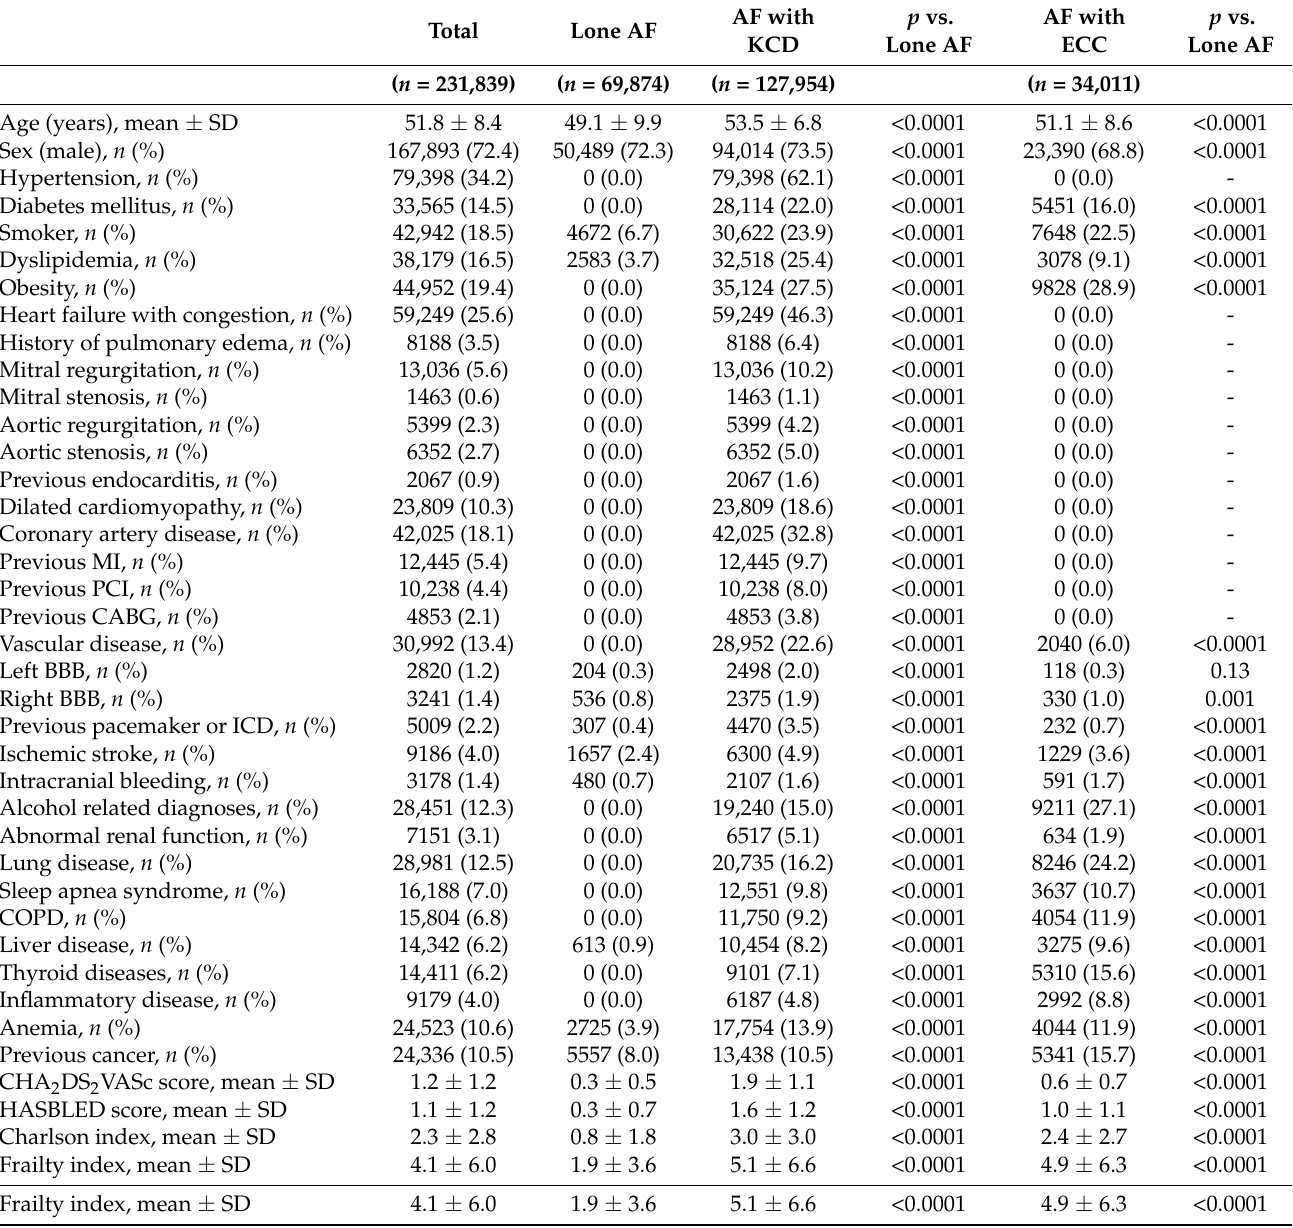
Table 1. Baseline characteristics of patients hospitalized in France (2011–2020) aged 18–60 with history of AF (KCD: known cardiac disease; ECC: extra-cardiac comorbidities). p vs. AF with Total Lone AF KCD Lone